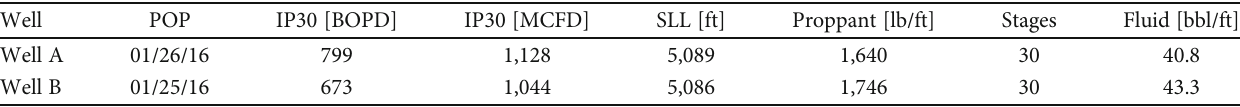
Table 1: The summary of production and completion information on well A and well